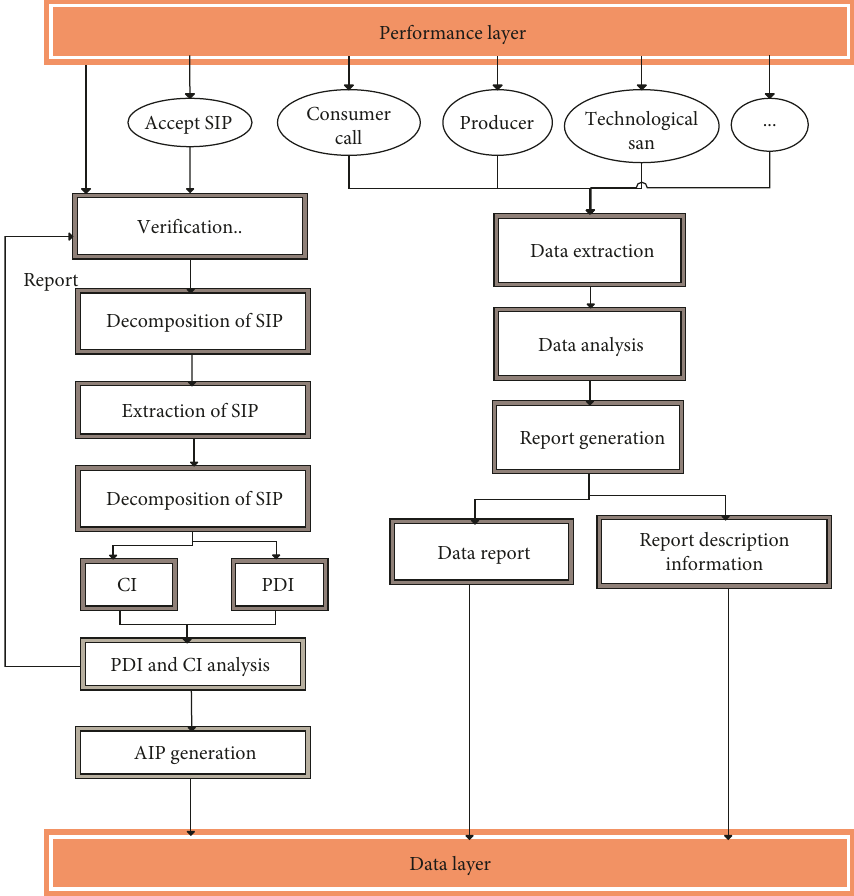
Figure 7: Flow chart of logical layer reception.